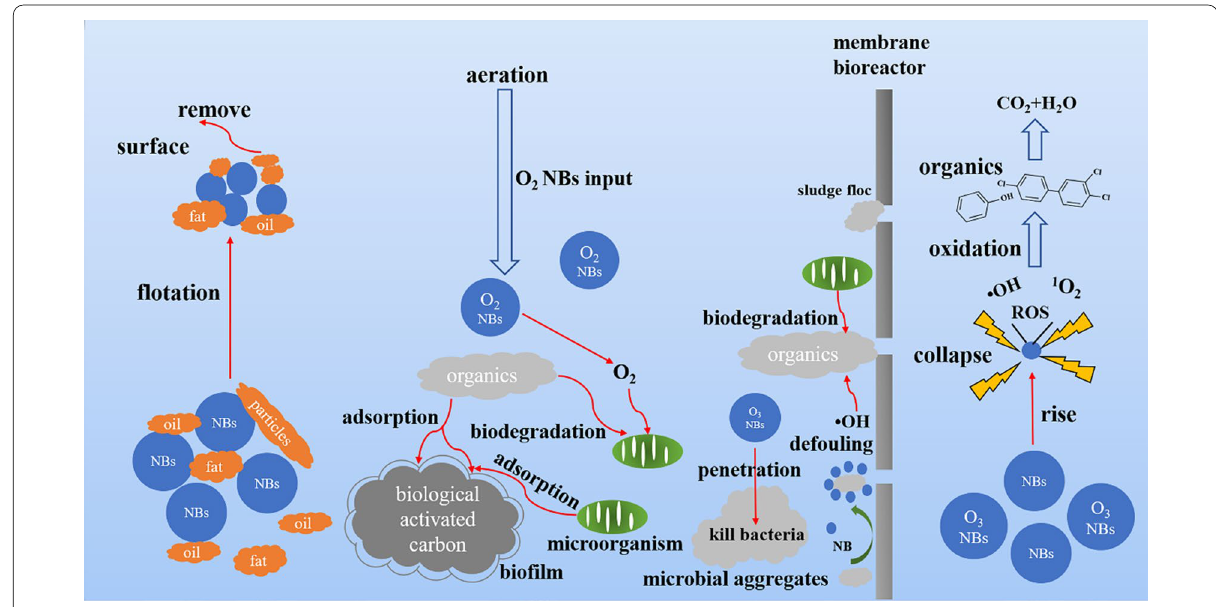
Fig. 1 The pathways for removing organic pollutants by bulk nanobubble-integrated technologies in